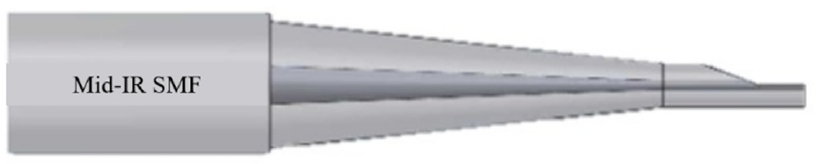
Figure 1. The scheme of light coupling from a mid-IR SMF to a DSCF through a tapered SCF